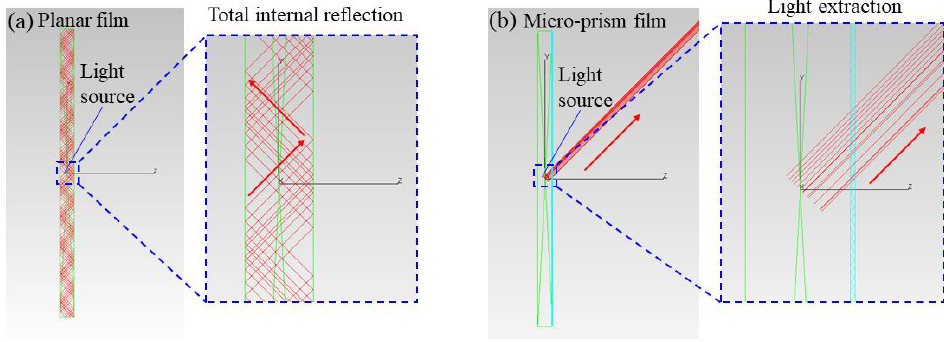
Figure 5. Schematic diagram of light propagation from exit surface to air (( a ) planar film ( b ) micro-prism film).